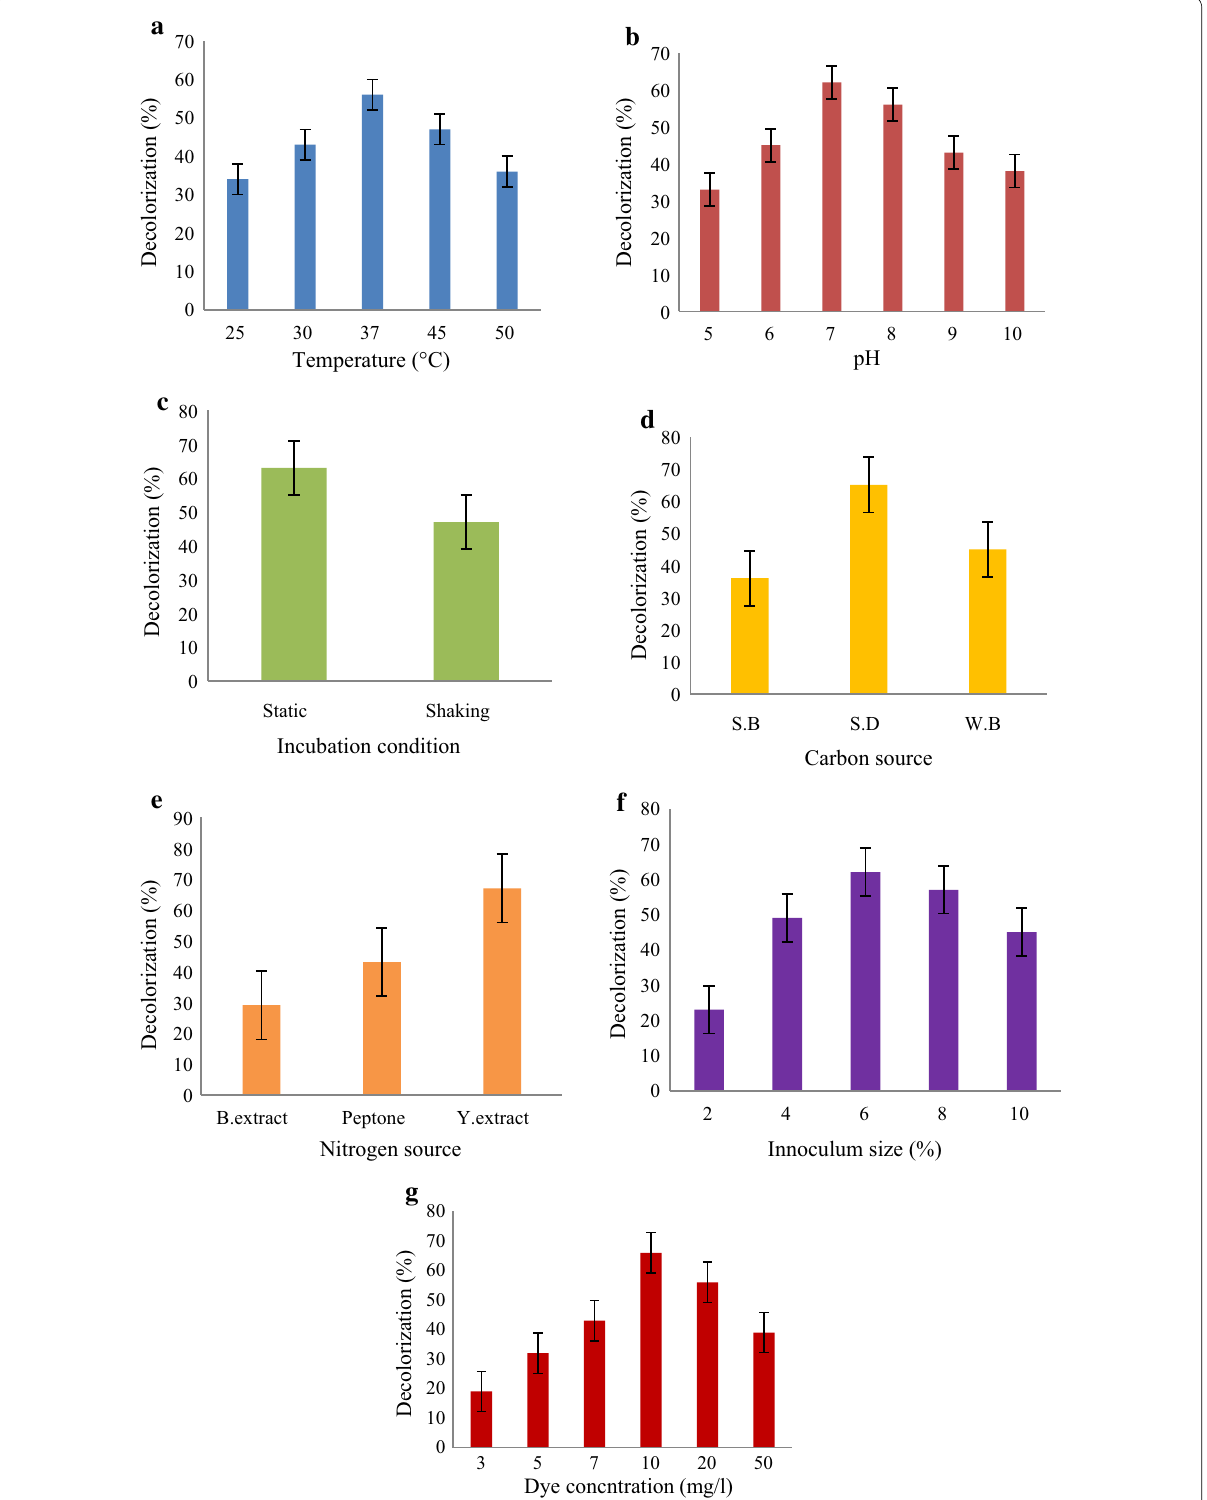
Fig. 2 Optimization of decolorization conditions for A. aquatilis 3c a temperature, b pH, c incubation condition, d carbon source, e nitrogen source, f inoculum percentage, and g dye